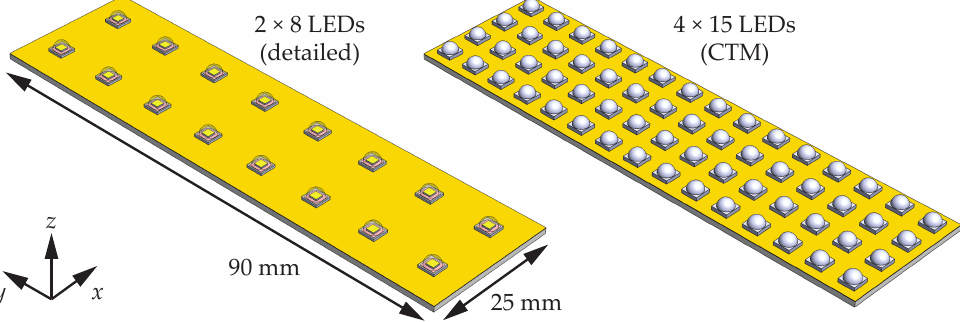
Figure 4. The LED module-level model. On the left an example is shown with N LED = 16 LED detailed models ( N x = 2 and N y = 8), and on the right an example is shown with N LED = 60 LED CTMs ( N x = 4 and N y = 15).